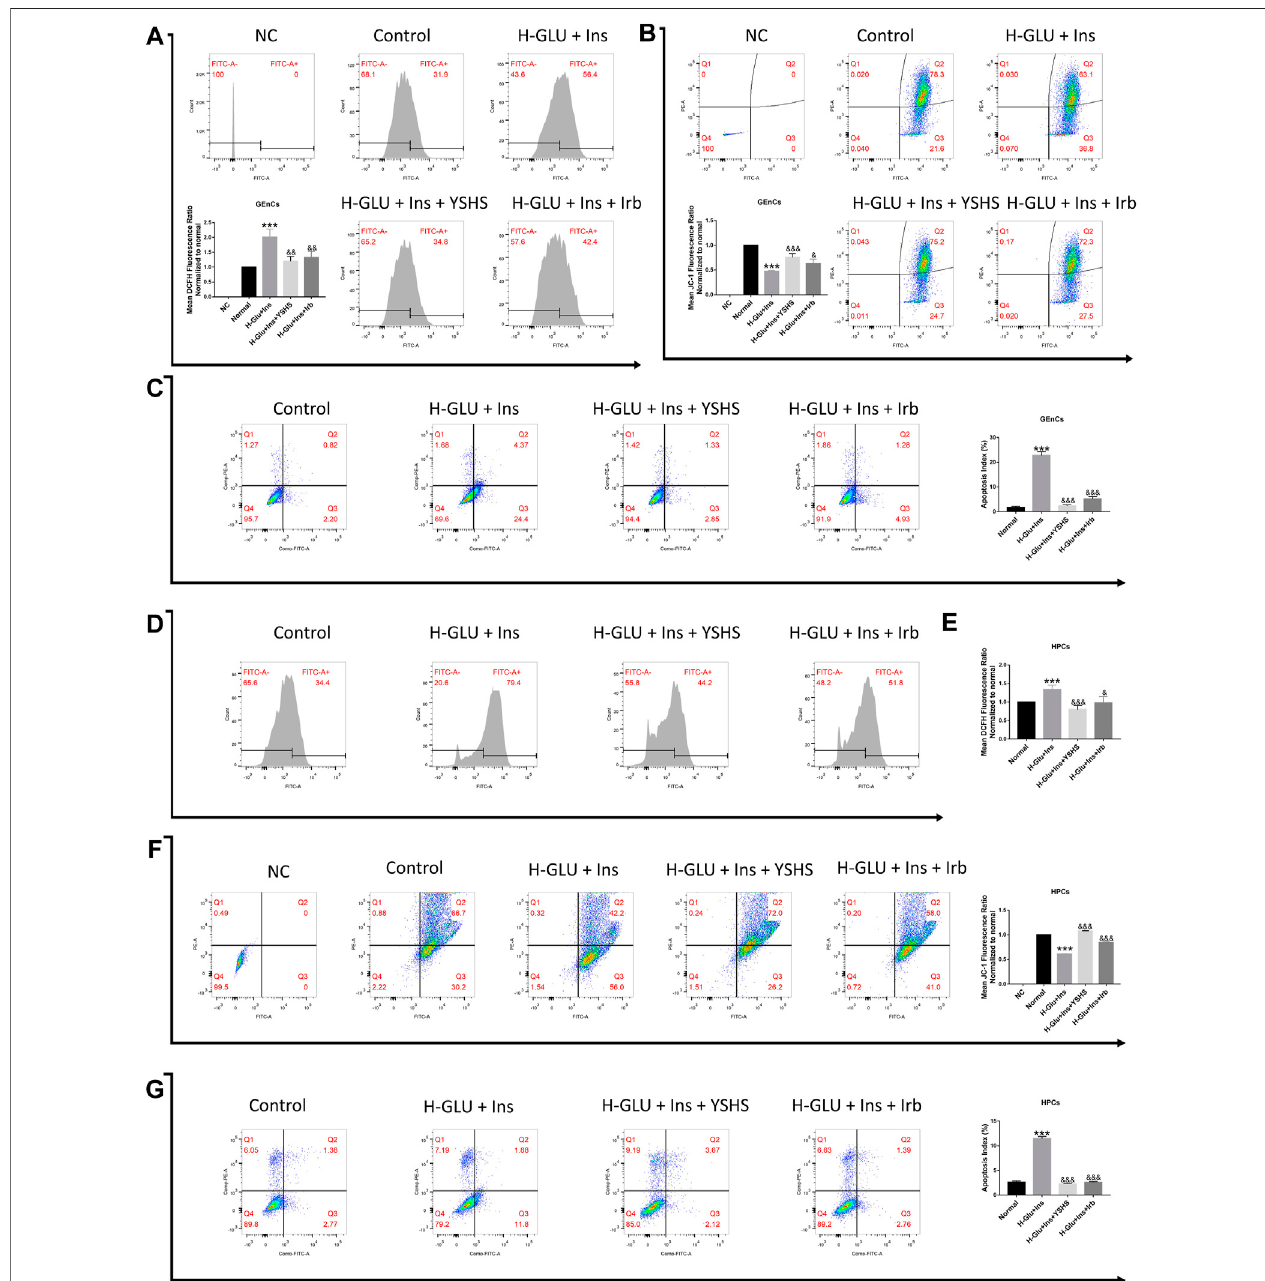
FIGURE8| EffectofYSHSonoxidativestress,mitochondrialmembranepotential( Δψ m),andapoptosisinGEnCcellsandHPCcells.IntracellularROSlevelswithin GEnC (A) and HPC (D,E) cells were measured by fl ow cytometry. JC-1 levels on GEnCs (B) and HPCs (F) cells were measured by fl ow cytometry. Apoptosis of GEnC (C) and HPC (G) cells were measured by fl ow cytometry. Values are presented as means ± SEM. * p < 0.05, ** p < 0.01, *** p < 0.001, vs. control; & p < 0.05, && p < 0.01, &&& p < 0.001, vs. H-Glu + Ins.